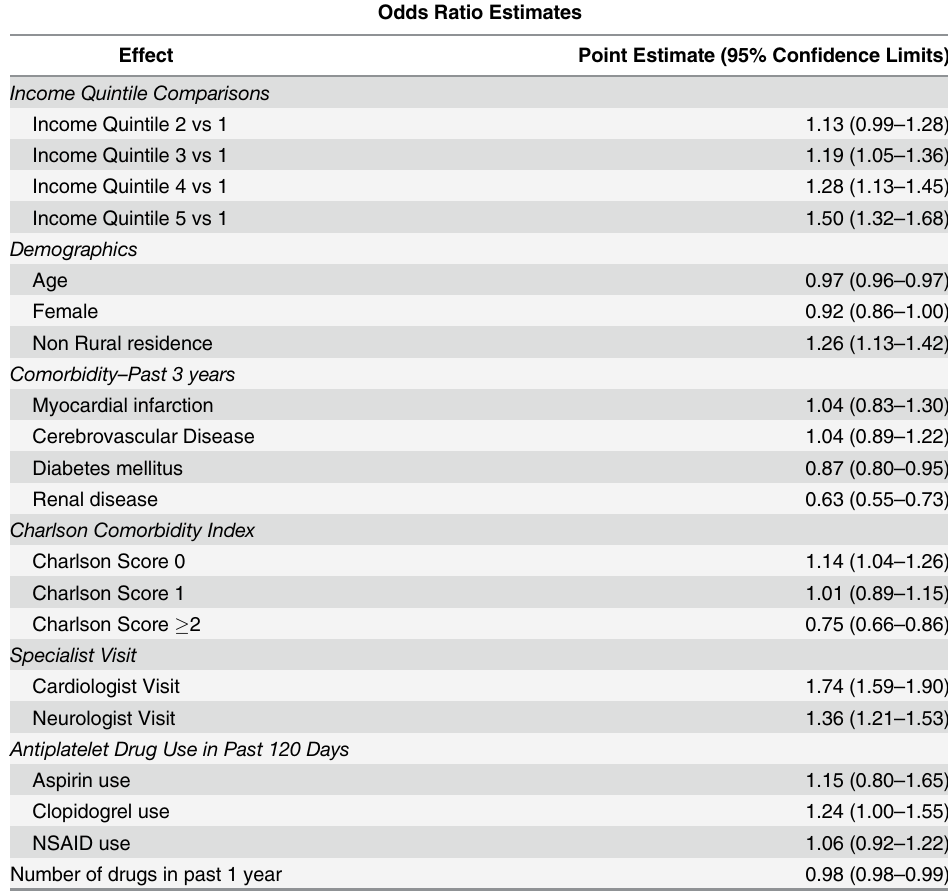
Table 1. Primary Analysis: Odds of Switching to Dabigatran Prior to ODBP listing of Dabigatran – Adjusted